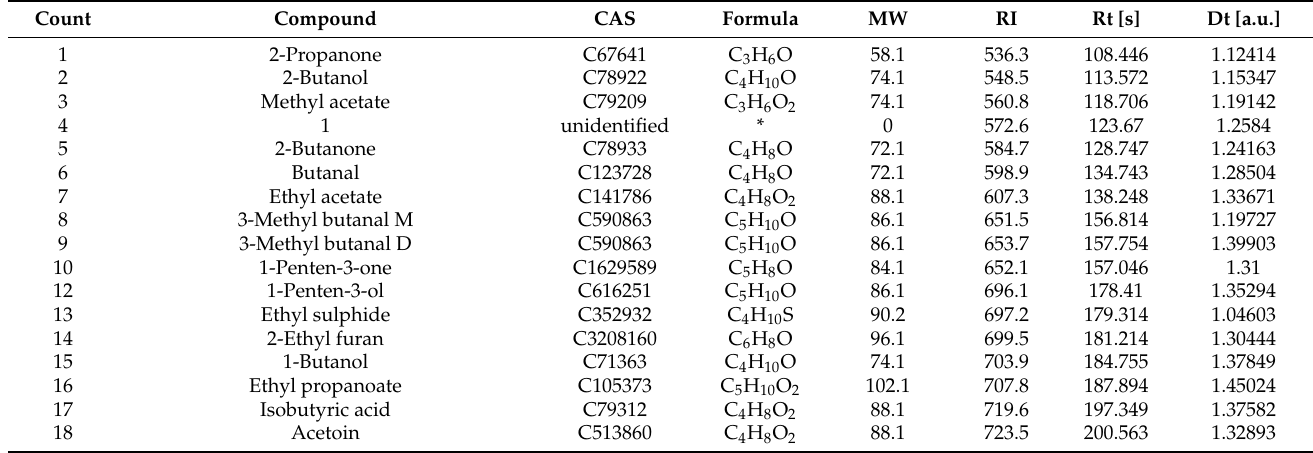
Table 1. GC-MS integration parameters of the fresh and dried AMR